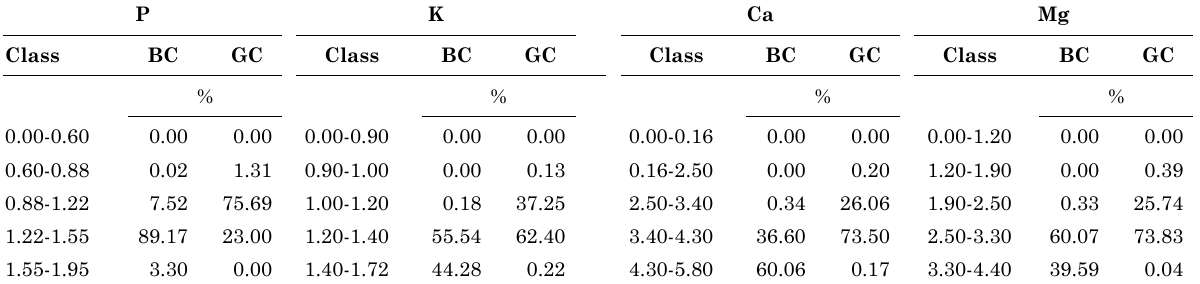
table 3. percentage of areas of e-type estimates of p, K, ca and Mg soil depletion rates, as function of numerical class of the soil depletion rates values in burnt cane (bc) and green cane (gc) harvest